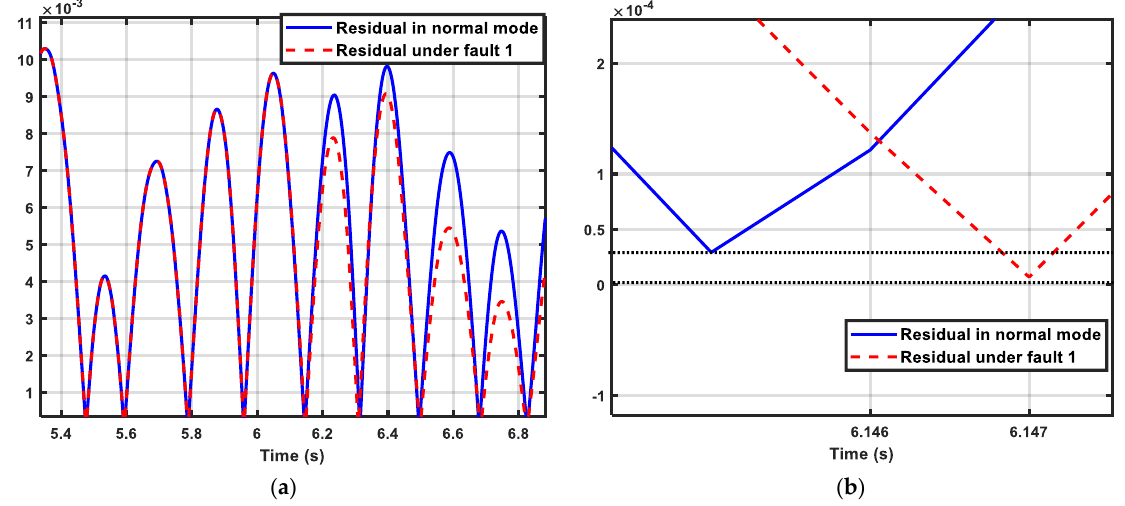
Figure 6. ( a ) Detection of actuator fault applied on the SG model at T d = 6.147 s, ( b ) zoomed-in view.